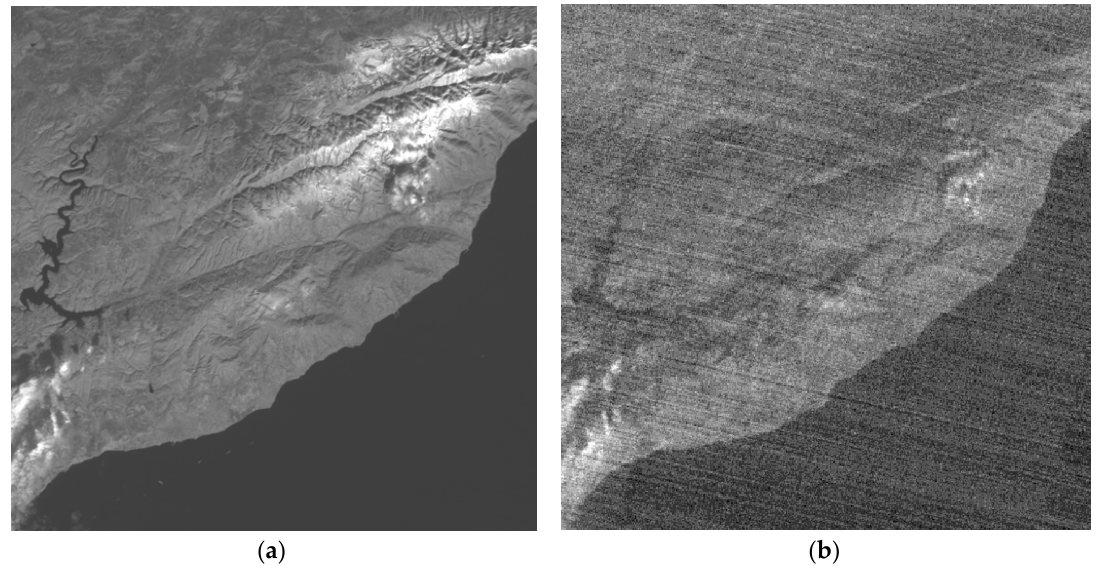
Figure 1. Visualized fragments of Sentinel-2 images of size 512 × 512 pixels in band #09 ( a ) and band #10 ( b ).